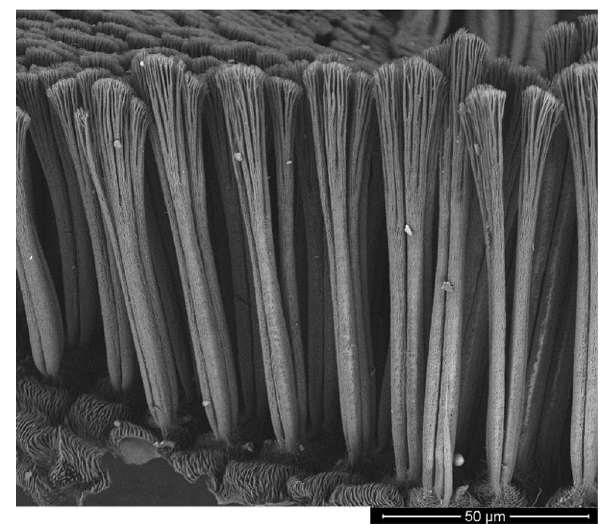
Fig. 6 Microscopic image of gecko fibers (individual setae, incl. the spatulae at the ends)